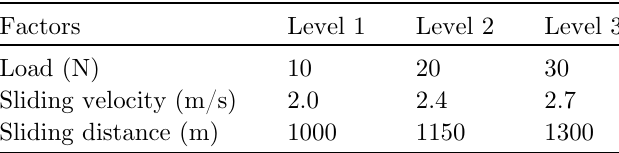
Table 2. Input process parameters with their values at three